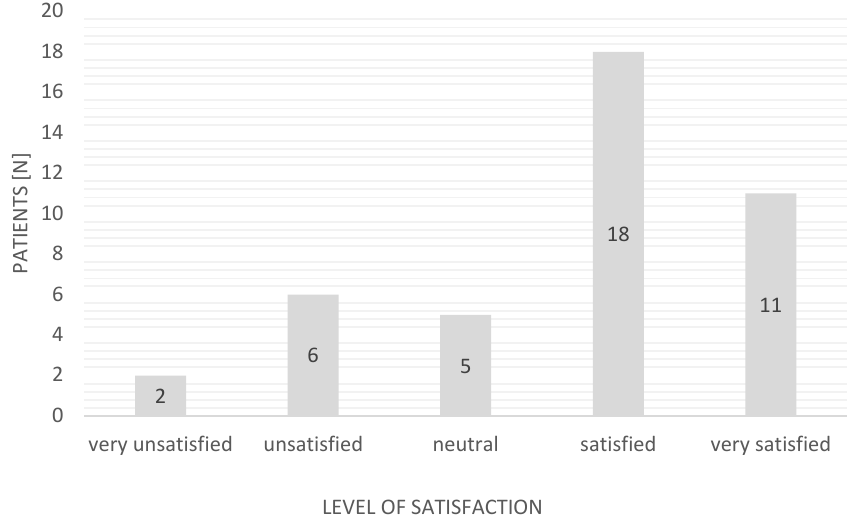
Figure 4. Patients’ satisfaction with the help provided by EMSs during the pandemic (Likert scale).